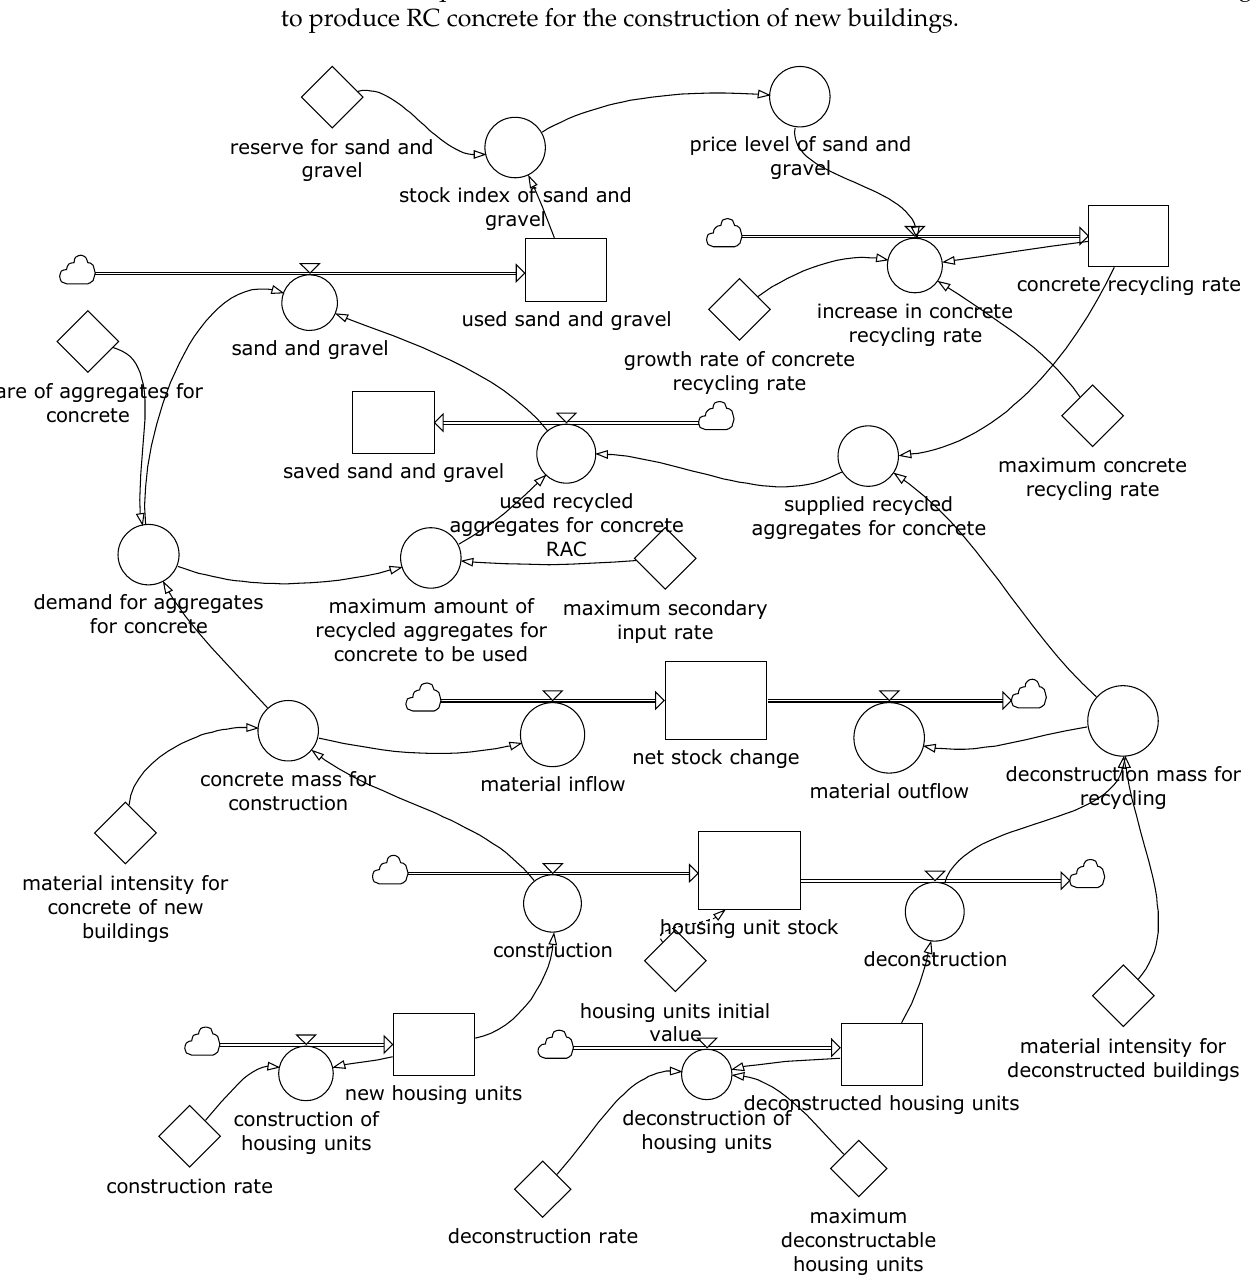
Figure 1. System dynamics (SD) model for the calculation of the resource conservation potential, calculated as the amount of primary raw material that could be saved by producing recycled aggregates for concrete (RAC) for use of recycling (RC) concrete in the German residential buildings construction sector.